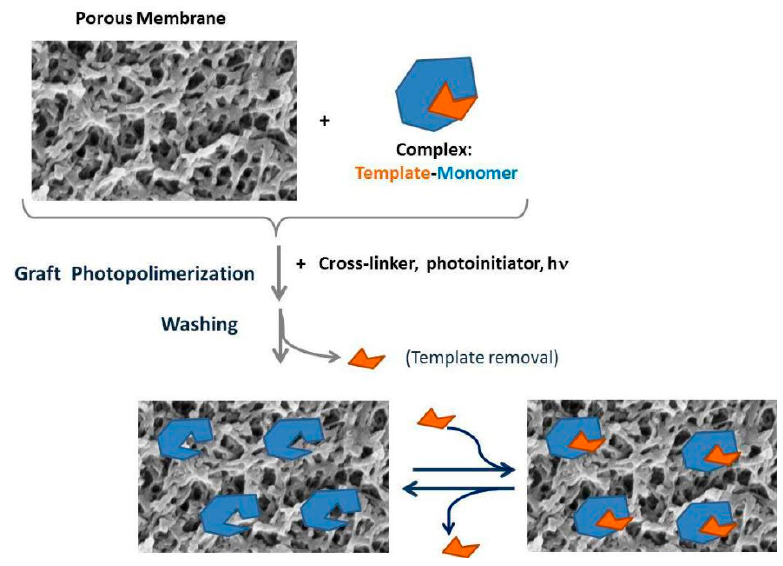
Figure 4. Scheme of surface photo-grafting for the formation of a molecularly imprinted sites in a membrane.